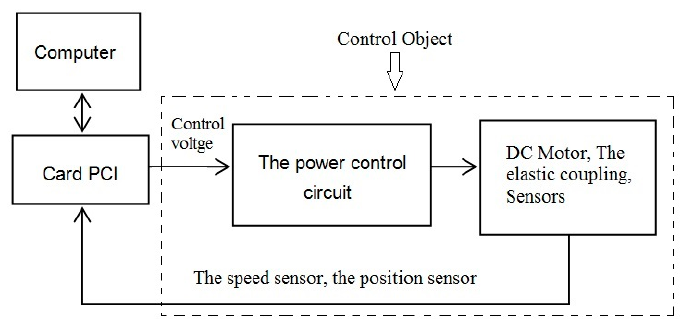
Figure 4. The connection diagram of the system.